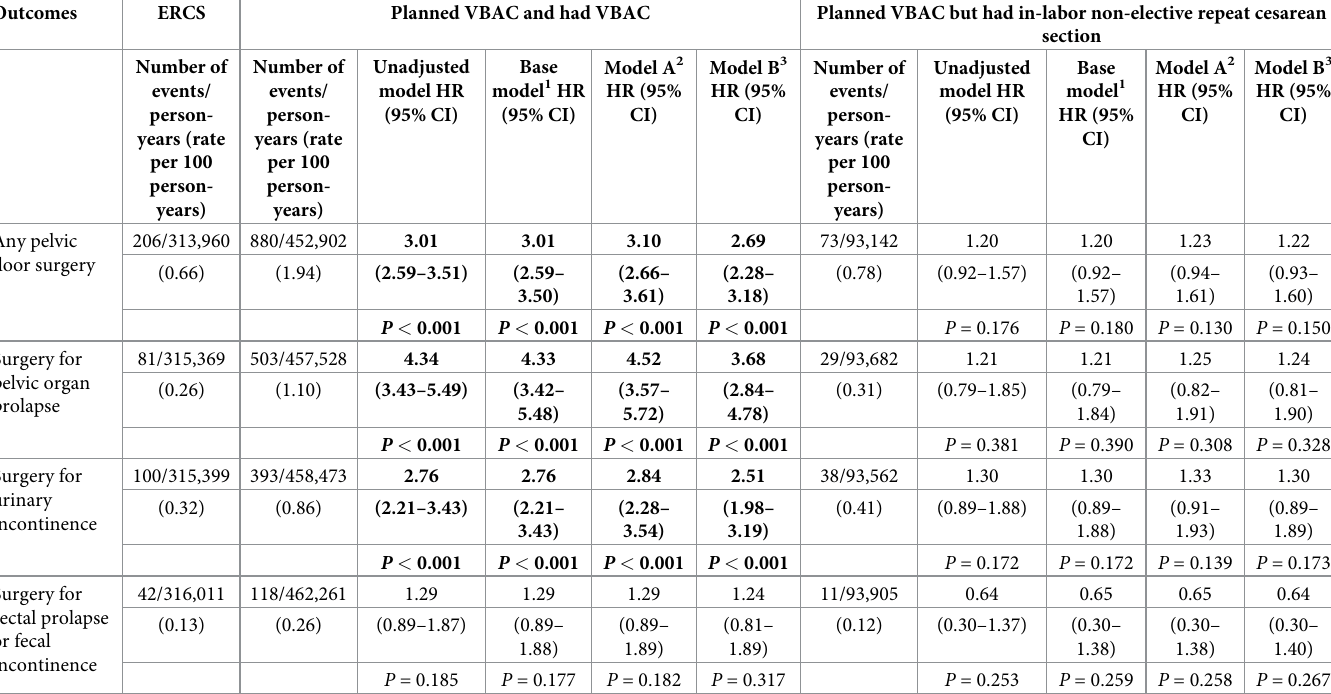
Table 4. Outcomes according to actual mode of birth—Planned VBAC and had a VBAC and planned VBAC but had in-labor non-elective repeat cesarean section compared to